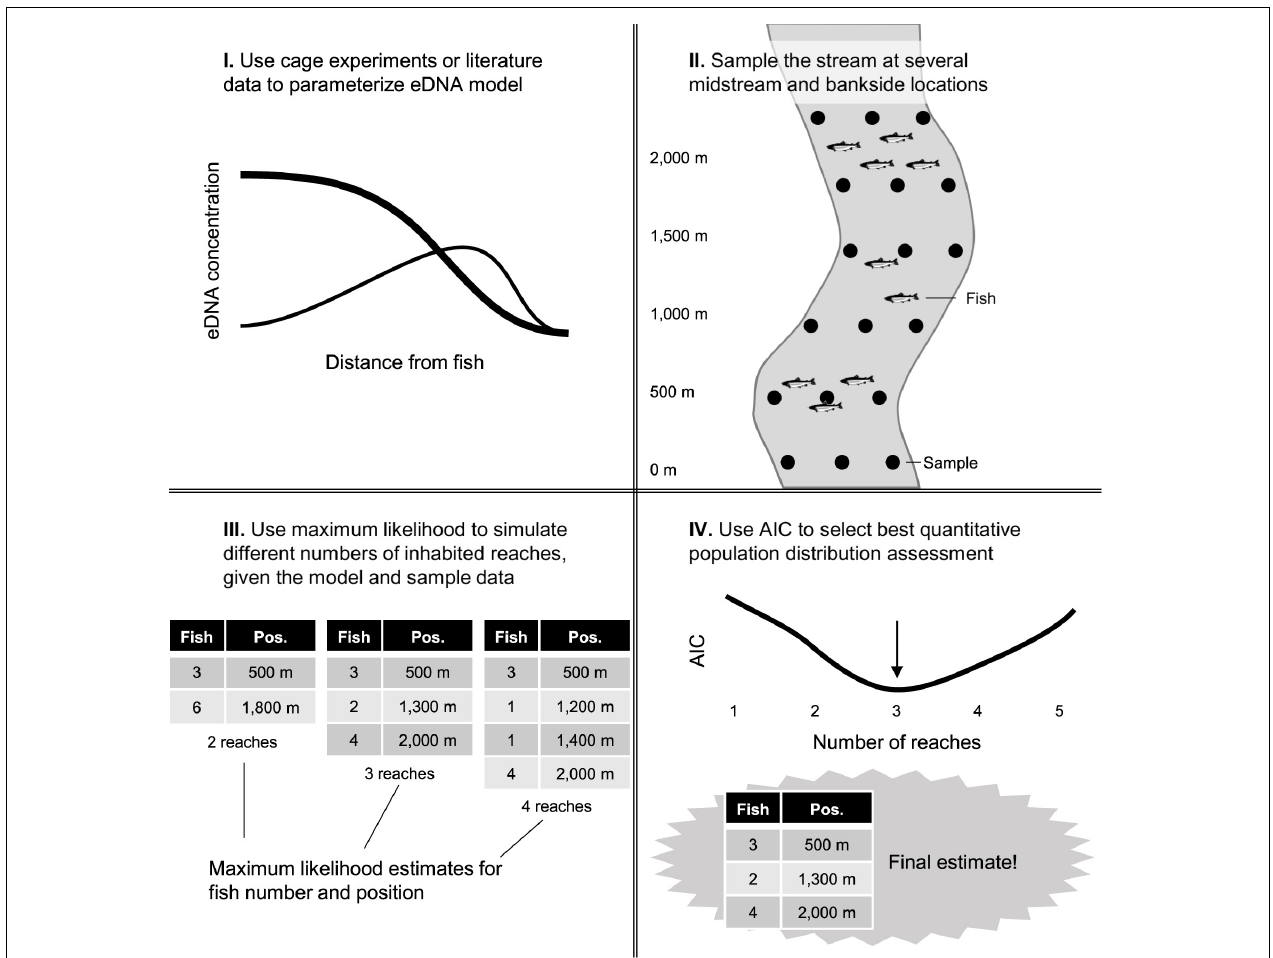
FIGURE 7 | Workflow for eDNA-based quantitative population distribution assessment in streams. Once a sufficient model of eDNA dynamics is constructed for a particular stream or stream type, sampling and maximum likelihood simulations can give estimates of fish numbers and